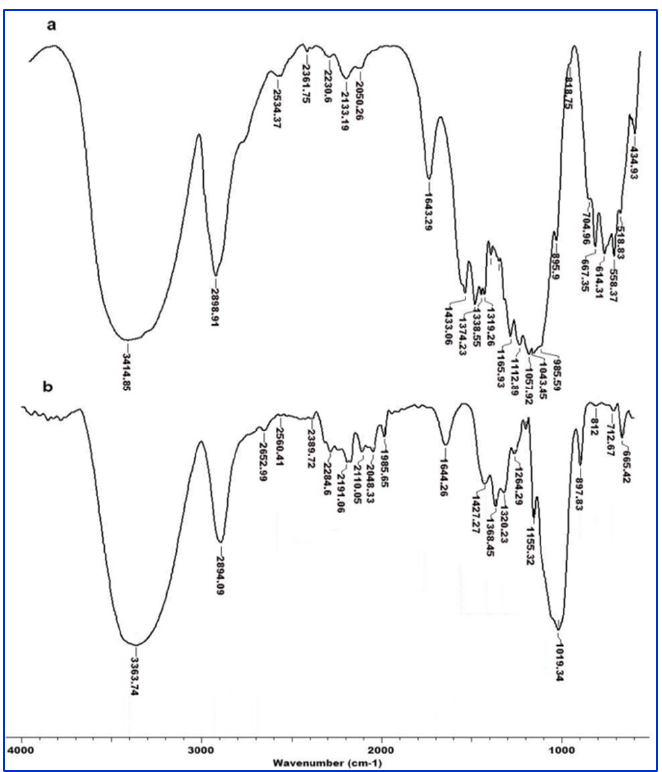
Figure 4. FTIR spectra of microcrystalline cellulose ( a ) and microcrystalline cellulose regenerated from ionic liquid solution ( b ).